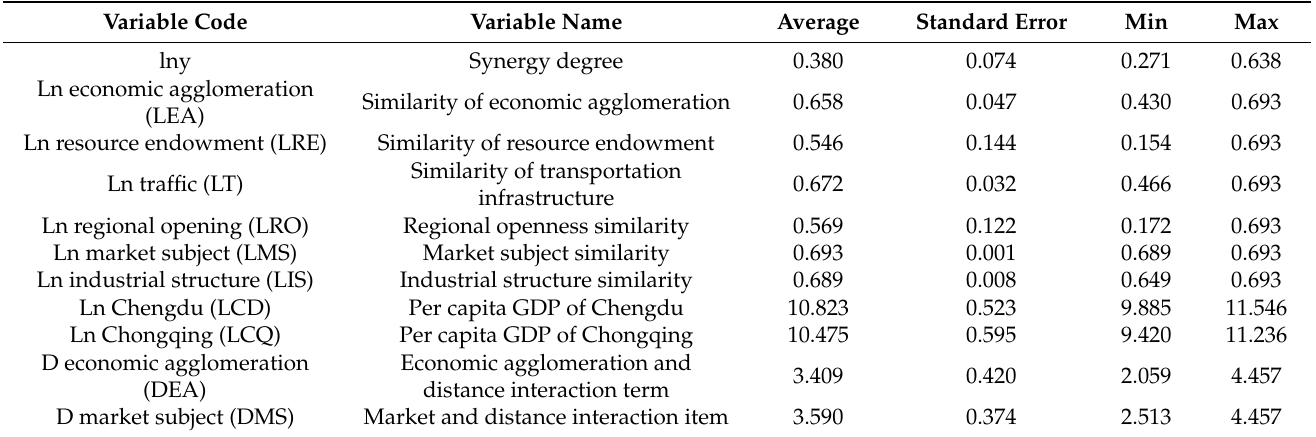
Table 2. Descriptive statistics of